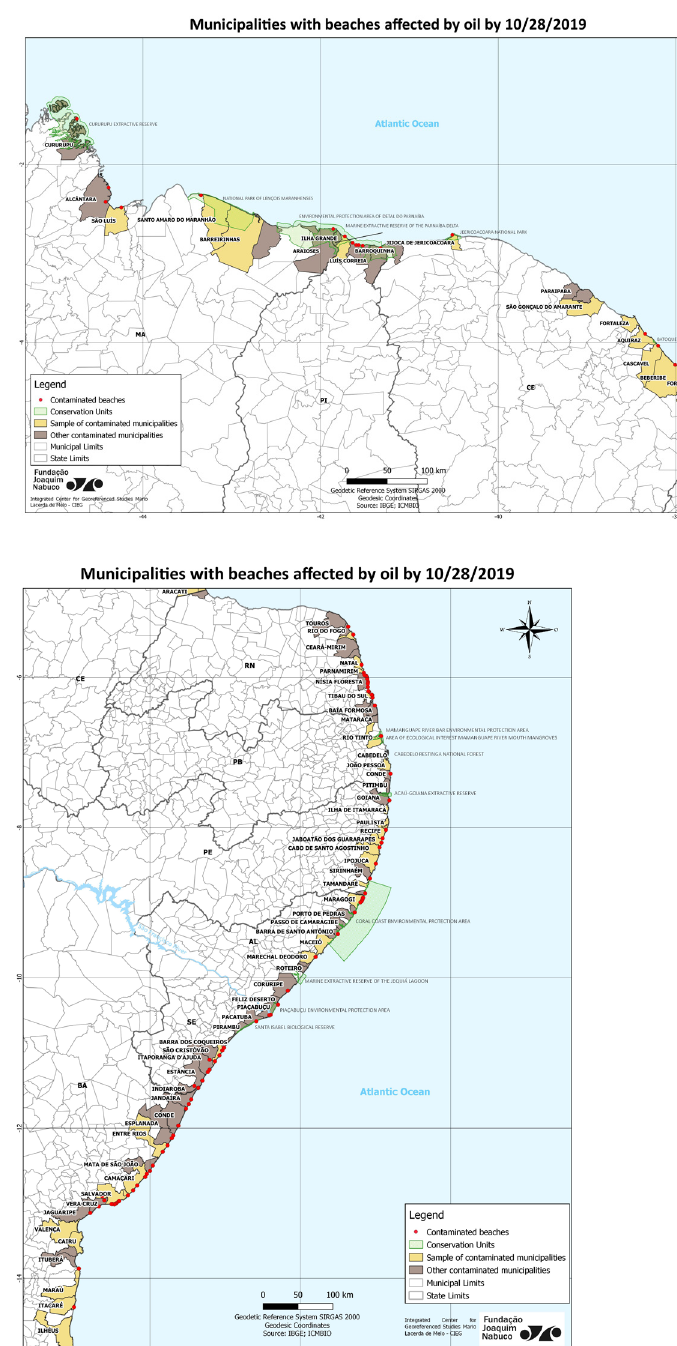
Figure 5. Map of beaches and municipalities affected by the disaster on the east coast of northeastern Brazil (top) and map of beaches affected by the disaster on the north coast (bottom). Source: Authors’ elaboration based on IBGE (2018) and IBAMA (2019)